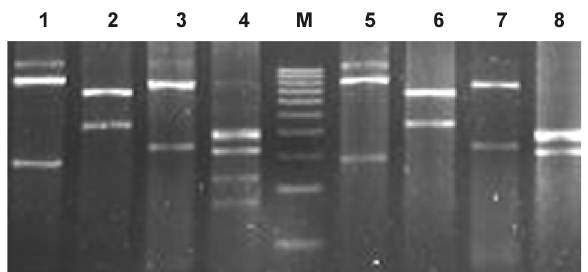
Figure 1 – PCR product from amplification of NAT2 analyzed on 2% agarose. Lane M-100 bp ladder, lane 1, 2, 3, and 4 are in control samples and lane 5, 6, 7 and 8 are in bladder cancer patients. Lane 1 and 5 indicate BamH1 digestion (NAT2*7), lane 2 and 6 Kpn1 digestion (NAT2*5), lane 3 and 7 Alu1 digestion